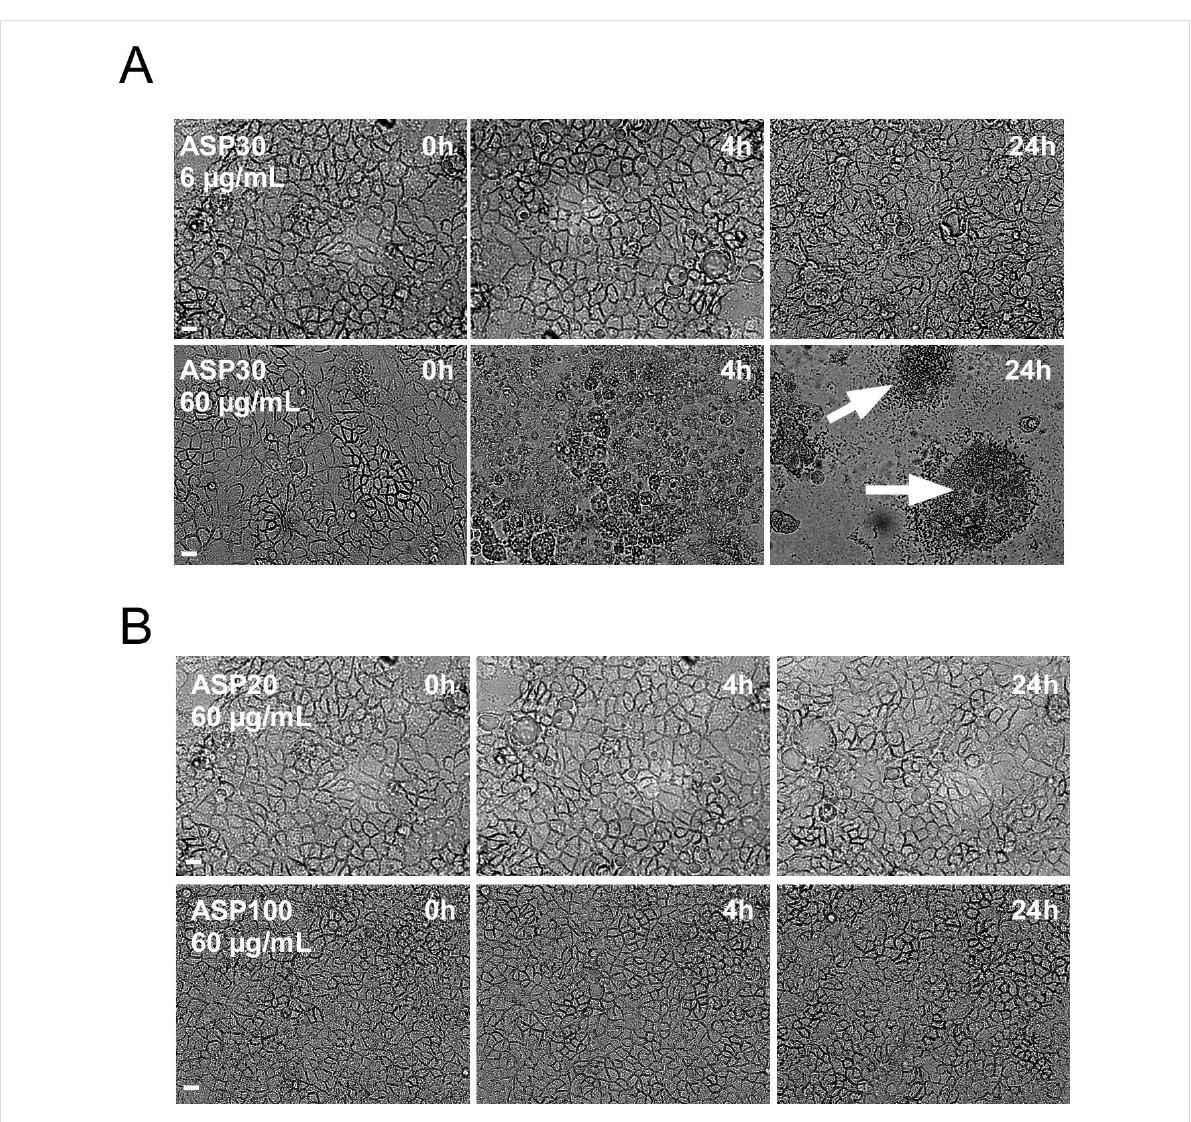
Figure 2: Microscopy-based assessment of cell vitality by analyzing ASP-induced morphological changes. (A/B) Caco-2 morphology was recorded by phase contrast microscopy. Cells were exposed to the indicated doses of the different ASP ((A) ASP30 and (B) ASP20 or ASP100) for 4 h in serum- free DMEM. Subsequently, cells were washed twice with DMEM and further cultivated in DMEM containing 10% FCS for 20 h prior to microscopic inspection. Scale bar = 10 µm. Arrows highlight loss of adhesion and cell clumping as signs for